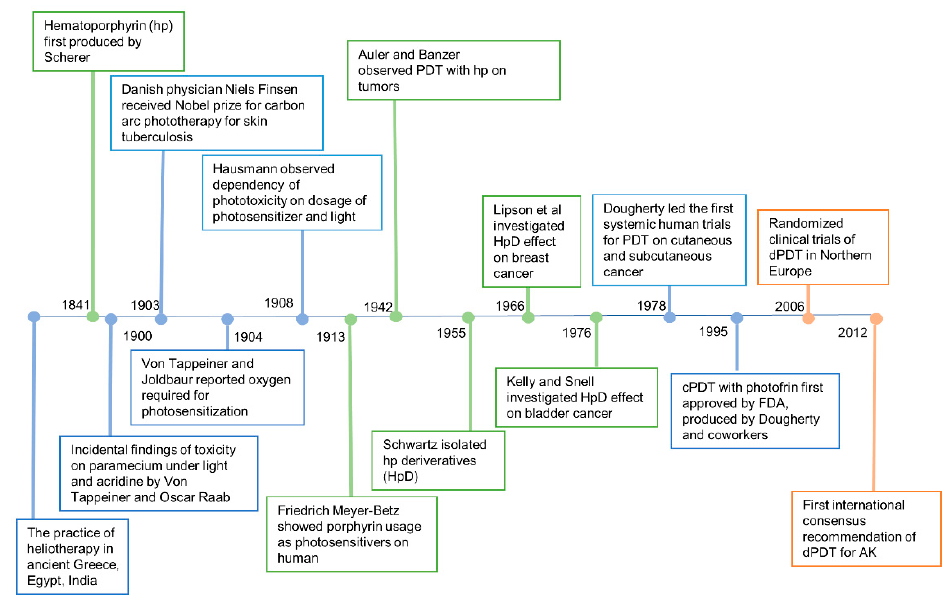
Figure 3. History of photodynamic therapy.